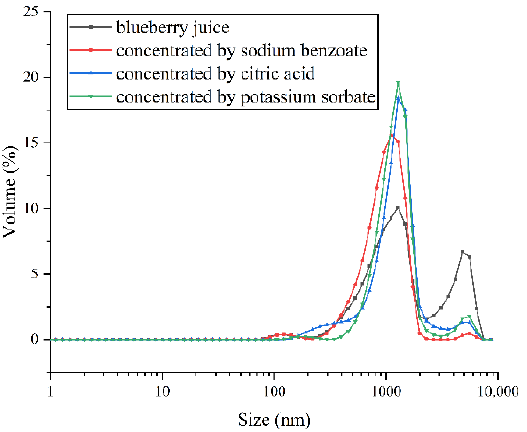
Figure 4. Size distribution of original and concentrated blueberry juices.